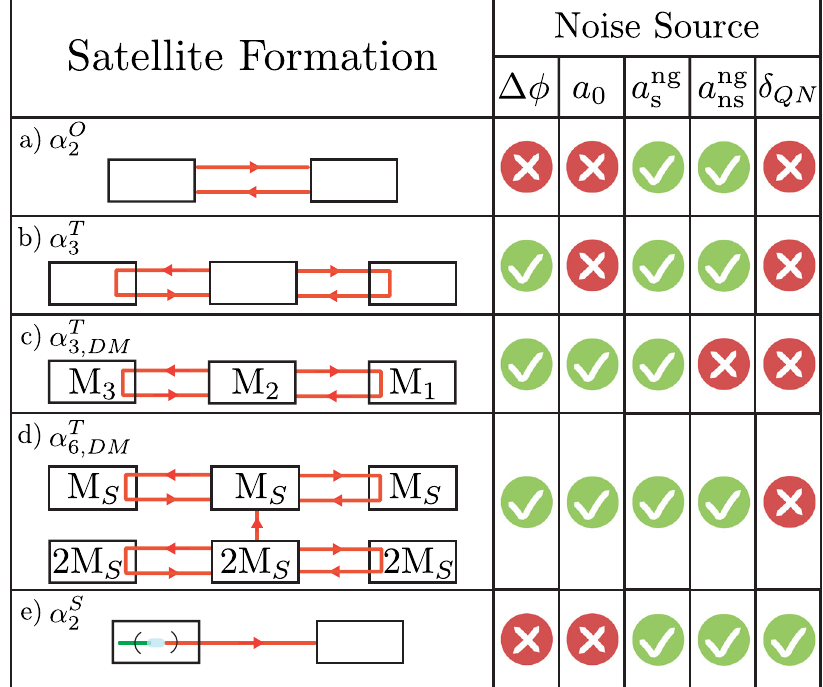
Fig. 2 Possible future mission formations. Possible formations are denoted by α i , where i represents the technique being used, j represents the j ; k , b three satellite formation number of satellites used and k indicates if satellites of different mass are necessary. a Original two satellite formation α O 2 , c three satellite differential mass formation with TDI α T , d six satellite differential mass formation with TDI α T and e two satellite with TDI α T 3 3 ; DM 6 ; DM . These allow the removal of various noise sources; laser phase noise Δ ϕ , accelerometer instrument noise a 0 , formation using squeezed light α S 2 ng ng δ α T stationary and non-stationary non-gravitational accelerations, a , α T and α T all ns , respectively, and quantum noise s and a QN . Formations 3 3 ; DM 6 ; DM ng use more than two satellites and so can remove laser phase noise through TDI. Formations α O , α T and α S use accelerometers and so the a s and 2 3 2 ng α T a and α T do not use ns terms are removed from the measurement at the expense of accelerometer instrument noise. Formations 3 ; DM 6 ; DM accelerometers and the non-gravitational accelerations are removed through appropriate combinations of the measurements, made possible by the different satellite masses. No scheme can completely remove quantum noise as each additional measurement adds a new source of quantum noise, however it can be reduced through the use of squeezed light as shown in formation α S 2